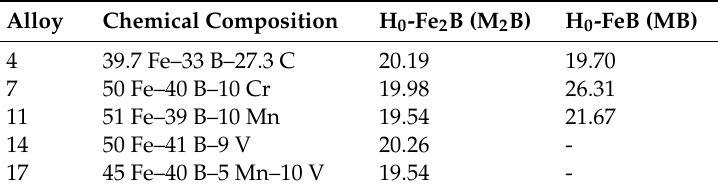
Table 4. Real hardness, H 0 (GPa), for Fe 2 B and FeB phases.